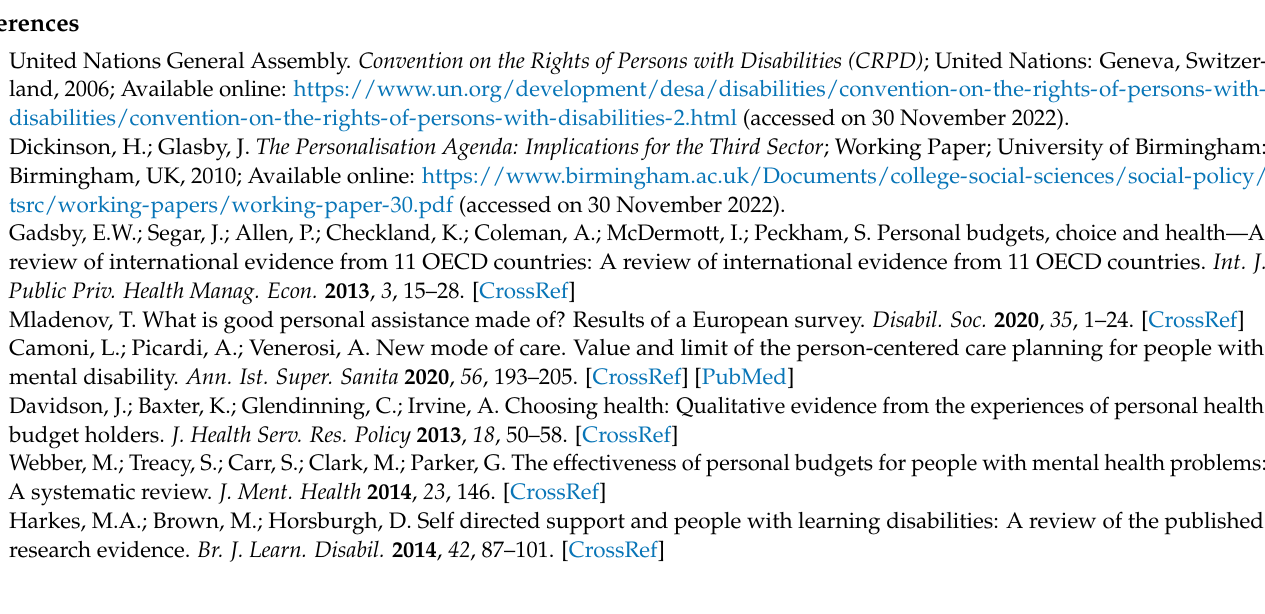
work; Table S2: Psycinfo; Table S3: Medline; Table S4: CINAHL; Table S5: Social care online; Table S6: ASSIA; Table S7: Excluded articles; Table S8: Quality assessment results by domain; Table S9: Detailed quality assessment using the Downs and Black Checklist; Table S10: Article characteristics; Table S11: Article outcomes reported; Table S12: Article outcome measures and findings; Table S13: Annual expenditures for children with intellectual and developmental disabilities in the Cash and Coun- seling Demonstration; Table S14: Annual expenditures in the Cash and Counseling Demonstration; Table S15: Cost per recipient per month in the Cash and Counseling Demonstration; Table S16: Mean weekly package costs; Table S17: Mean weekly package costs; Table S18: Mean cost per week by health service; Table S19: Mean weekly package